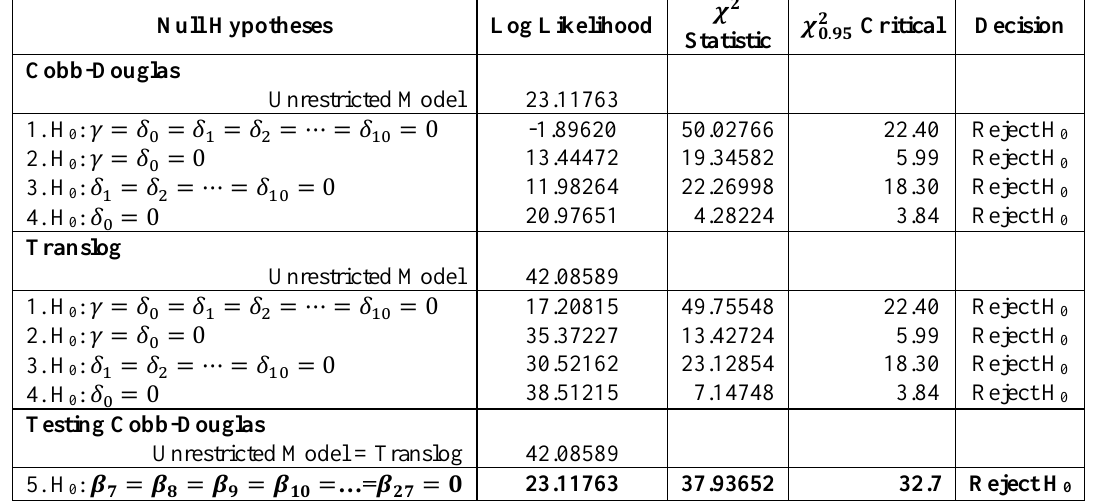
Table 7: Hypothesis tests for the stochastic frontier and inefficiency effects models.